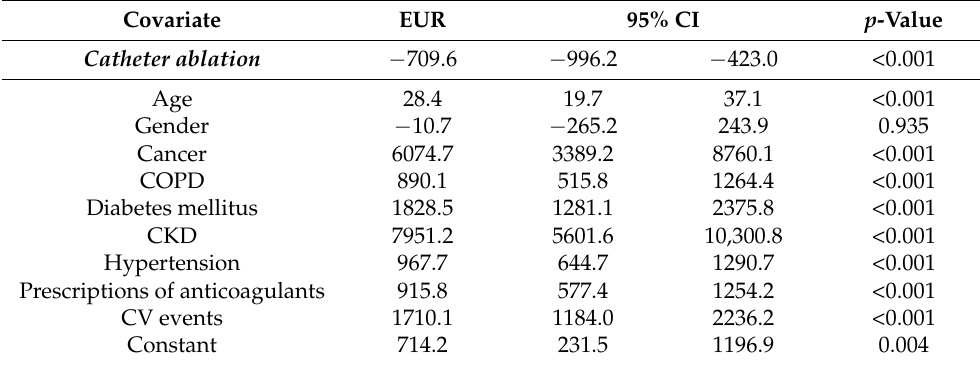
Table 3. Results of the GLM analysis of the direct healthcare